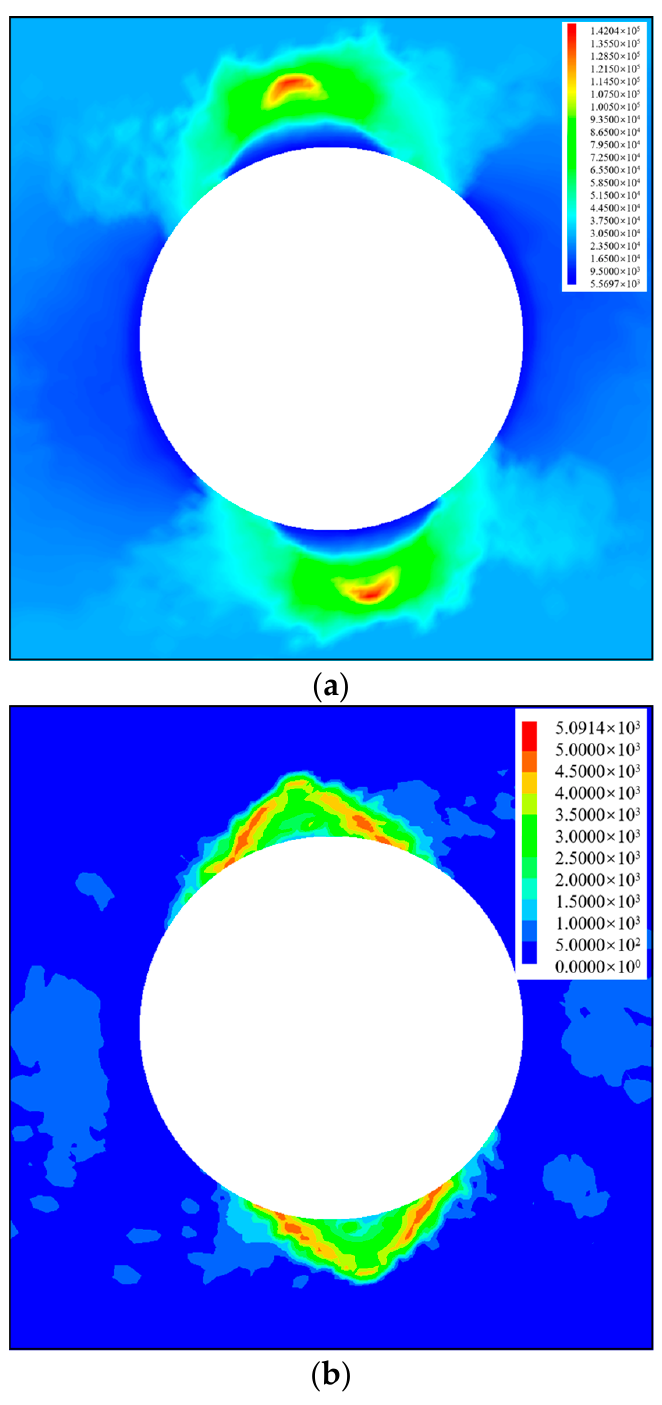
Figure 7. The energy density and its occurrence time after the energy release: ( a ) energy density after the energy release; ( b ) occurrence time of the maximum energy density.